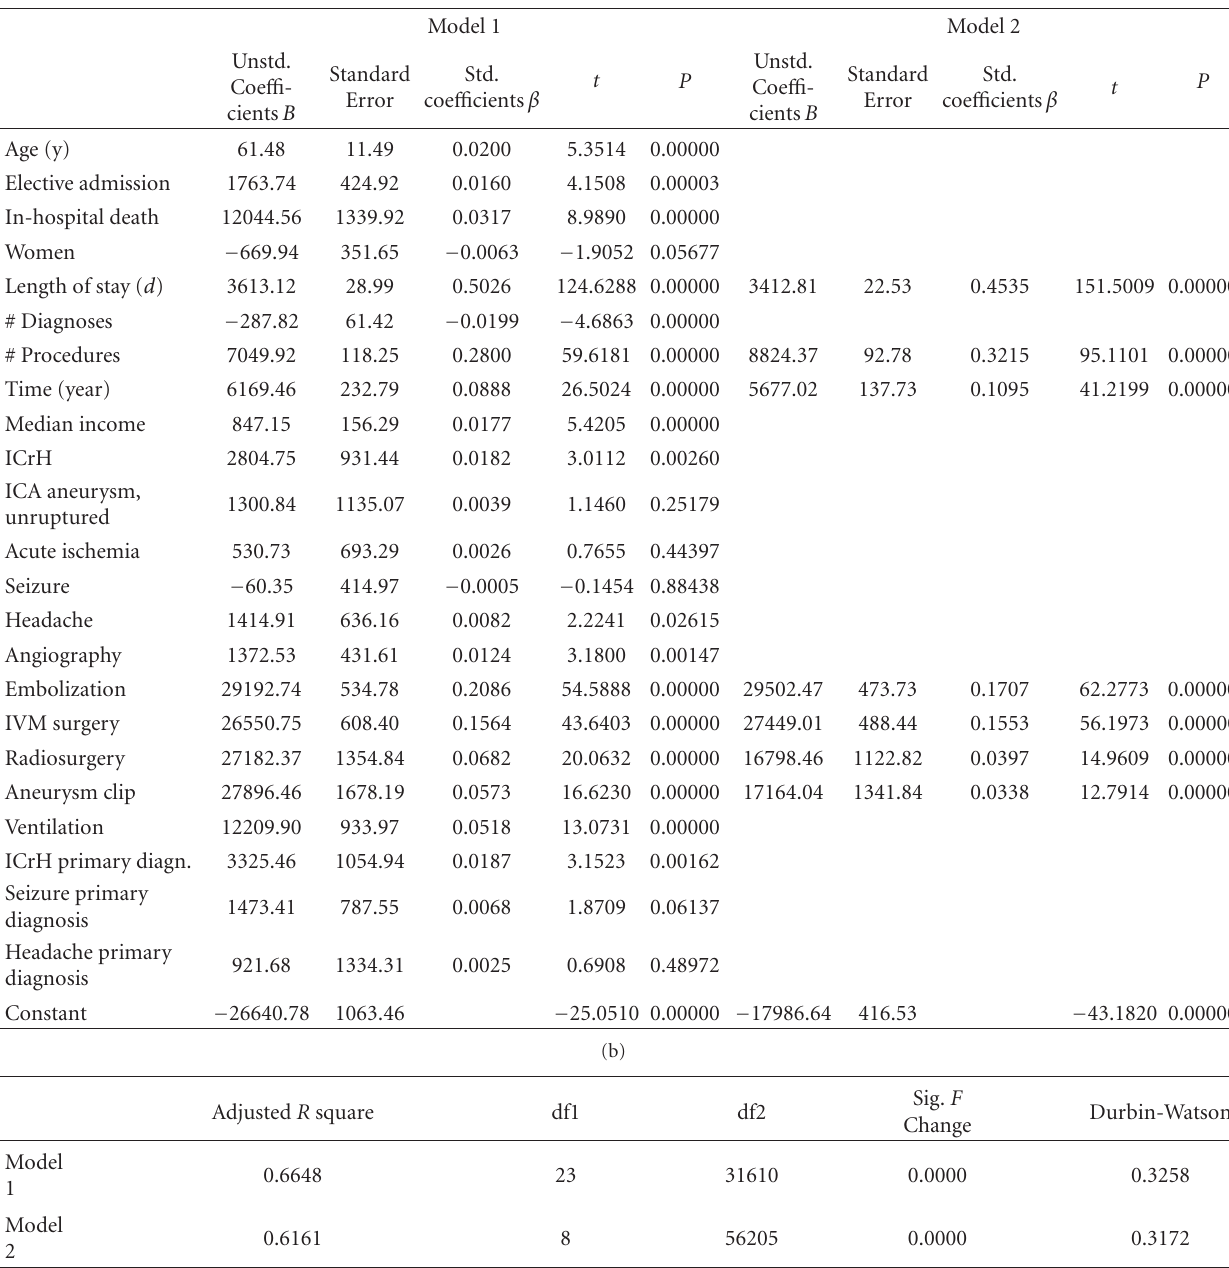
Table 4: Determinants of hospital